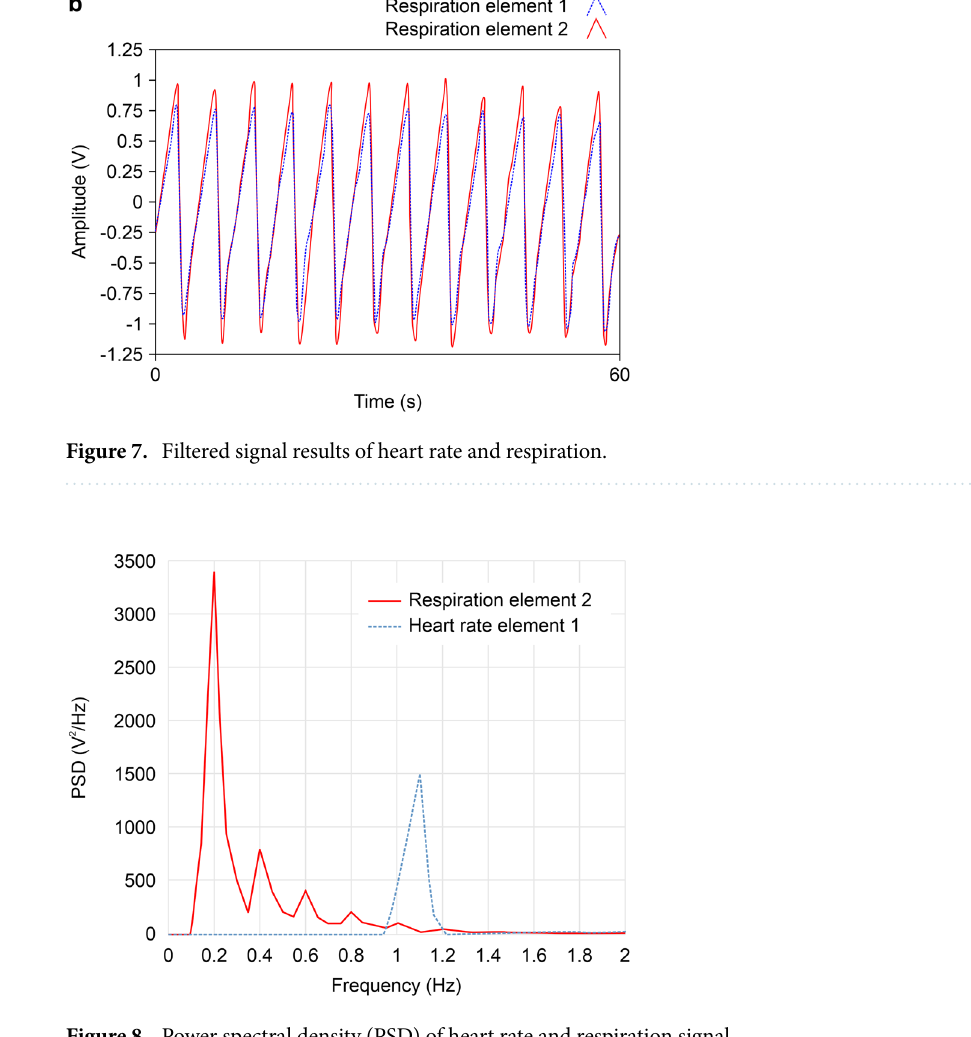
Figure 8. Power spectral density (PSD) of heart rate and respiration